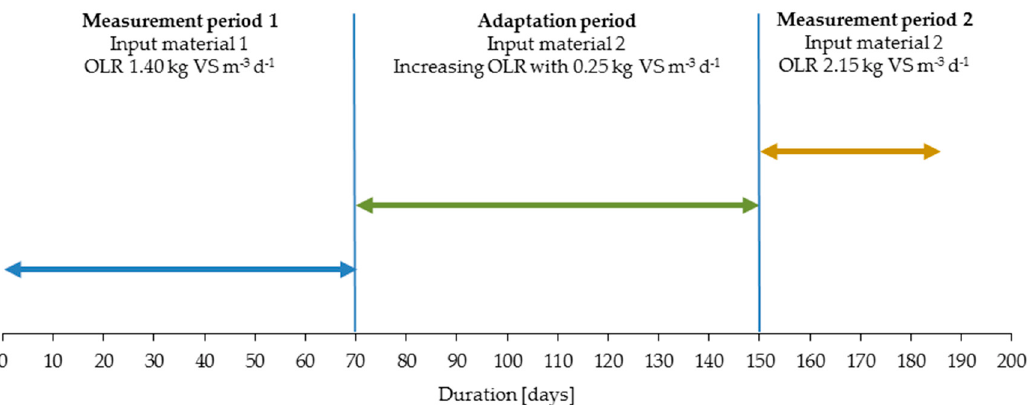
Figure 1. The overall timeline for the semi-continuous experiment.